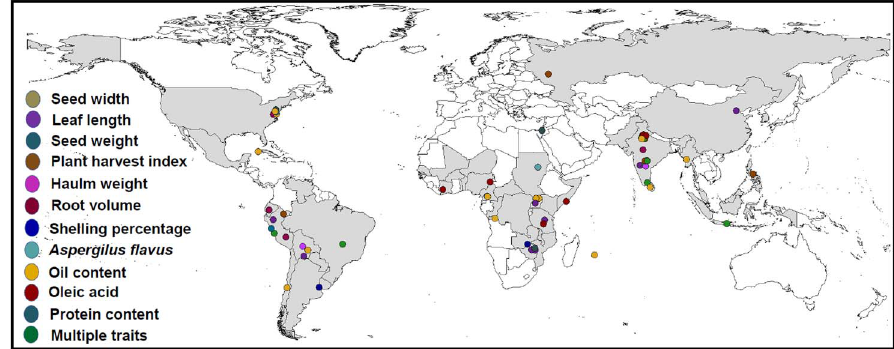
Figure 3. Genomewide distribution of trait-associated markers for different traits. Mapped SSR markers that showed trait association are represented on linkage groups (A01 to A10 and B01 to B10) while unmapped DArT features are assigned to A0 linkage group for representation.